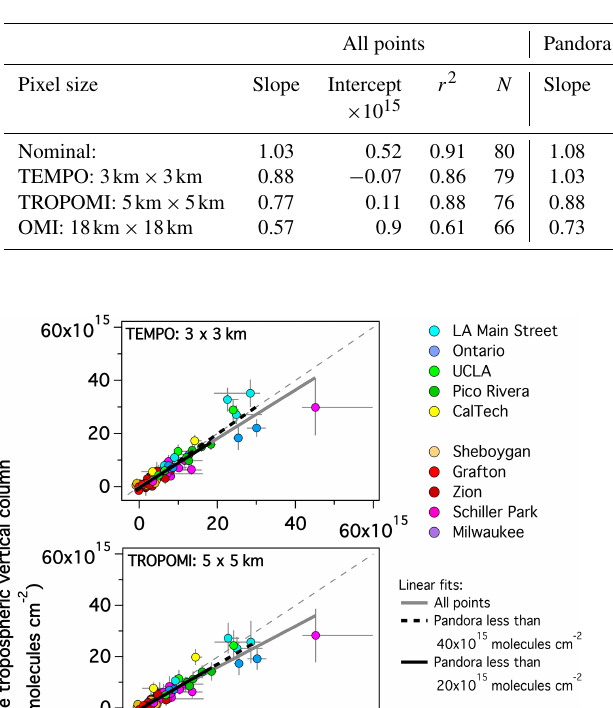
Table 3. Statistics between Pandora and the GeoTASO data at the nominal pixel size shown in Fig. 3 as well as the simulated pixel sizes for TEMPO, TROPOMI, and OMI products shown in Fig. 9.